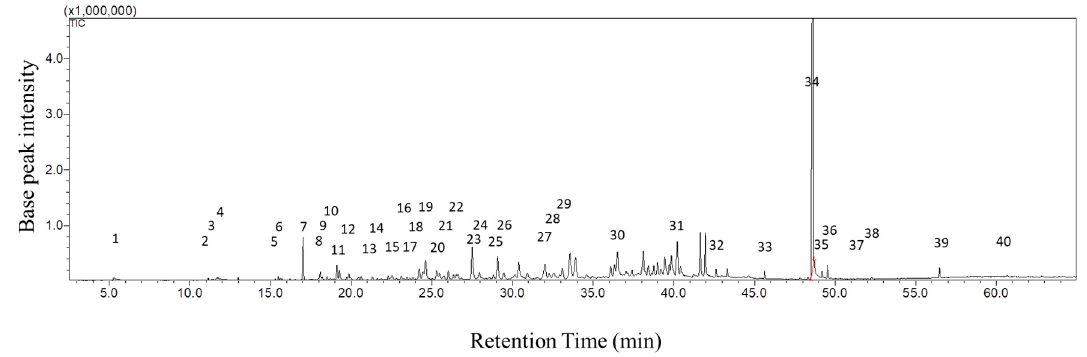
Figure 3. GC-MS chemical fingerprint of incense smoke from Kynam agarwood. Number indicates the identified compound, and the details of compounds are listed in Table 1. Table 1. List of compounds identified in the incense smoke from Kynam agarwood by GC-MS/MS. No.